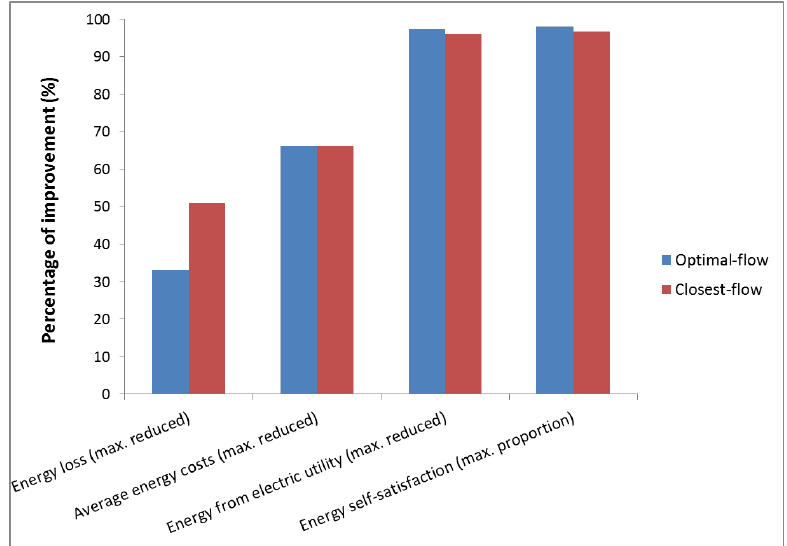
Figure 8. Comparison with assessment metrics of Optimal-flow Case and Closest-flow